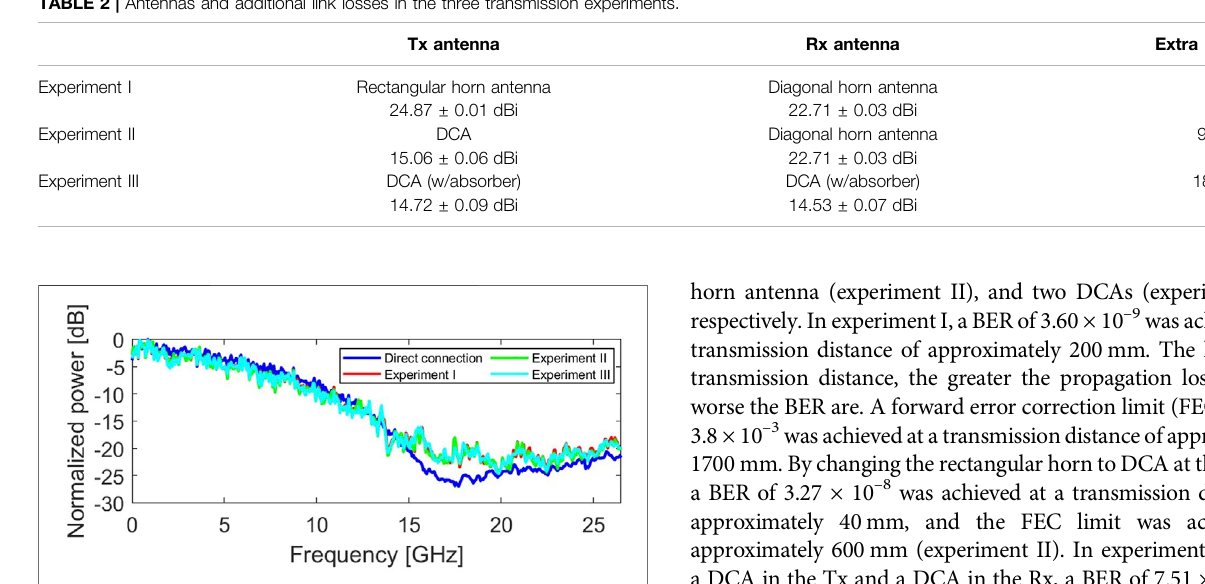
FIGURE 8 | Received signal spectra. The data rate was 17.5 Gbps. The spectra were obtained under the same BER conditions.